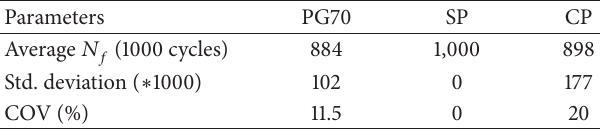
Table 6: Beam fatigue test